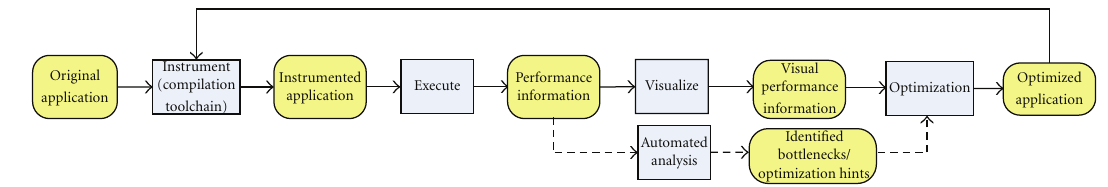
Figure 2: Performance of optimization